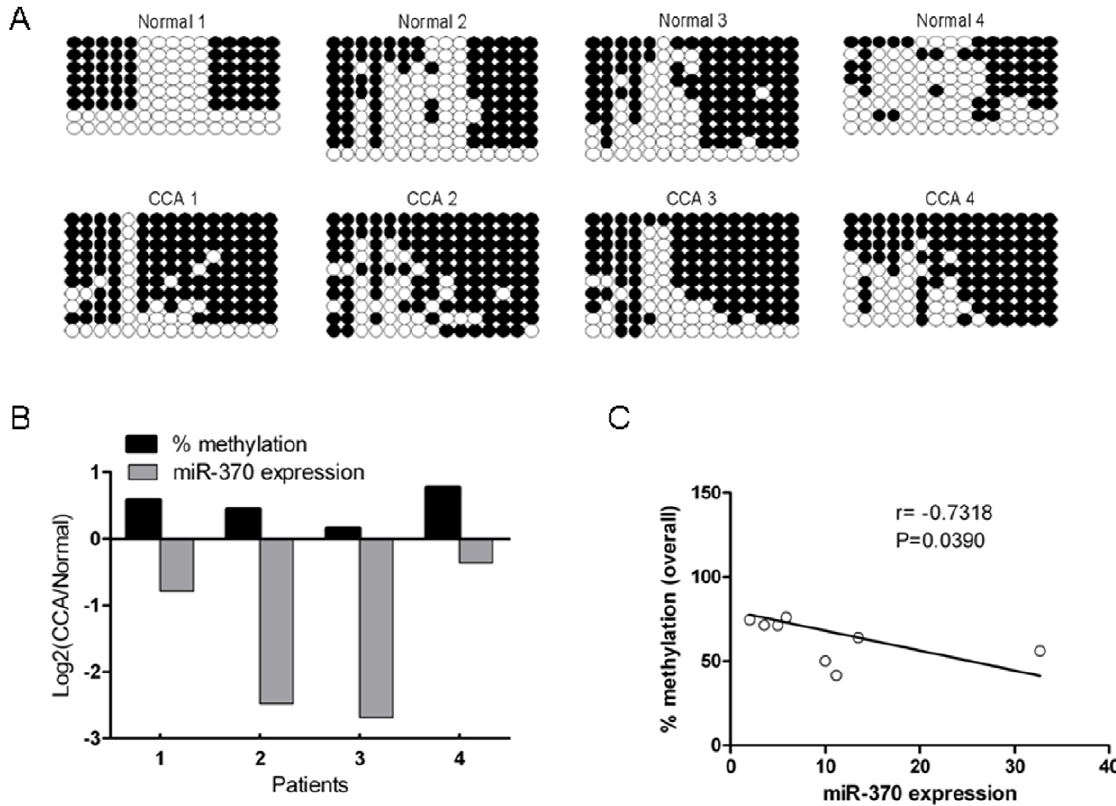
Figure 4. Methylation of IG-DMR-CG6 influences miR-370 expression. A. IG-DMR-CG6 is hypermethylated in human CCAs vs. matched normal tissues. Each line indicates a single clone, and each circle denotes the cytosine of a CpG site; filled and open circles represent methylated and unmethylated cytosines, respectively. B. miR-370 expression is inversely related to methylation at IG-DMR-CG6 in human liver specimens. X-axis - methylation rate, and miR-370 expression, Y-axis - human tissues. Percent methylation and miR-370 expression are expressed as a log2 of the ratio between the cancer and matched normal specimen. Since the data is expressed in logarithmic space, a positive value (as in the values for methylation for all 4 specimens) signifies more methylation in cancer vs. matched normal tissue. A negative value (as in the values for miR-370 for all 4 specimens) signifies a lower expression in cancer vs. matched normal specimen. These data demonstrates that for all 4 pairs of specimens, an increased in the methylation at IG-DMR-CG6 in cancer vs. matched normal is accompanied by a lower level of miR-370 in cancer vs. matched normal specimen. C. The expression of miR-370 is inversely correlated with level of DNA methylation. X-axis- miR-370 expression, Y-axis- overall methylation rate (%). r-correlation coefficient, p- P value.